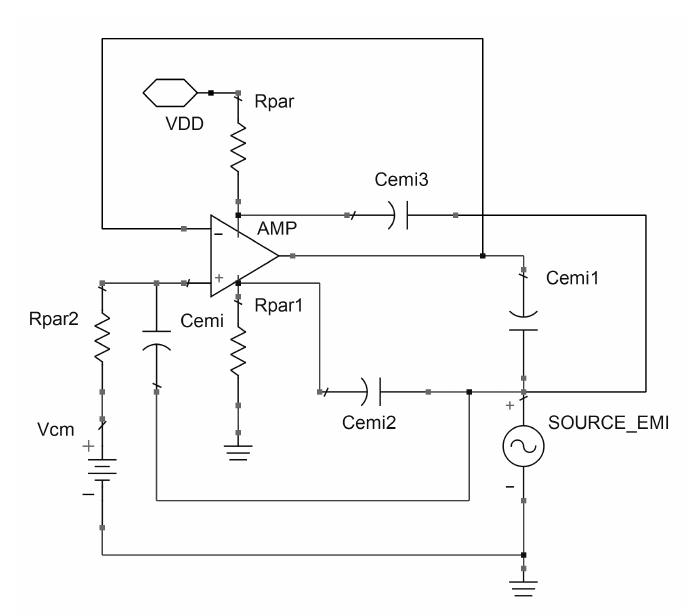
Figure 6. Circuit for the simulations of the EMI effect: EMI coupled to all of the pins.